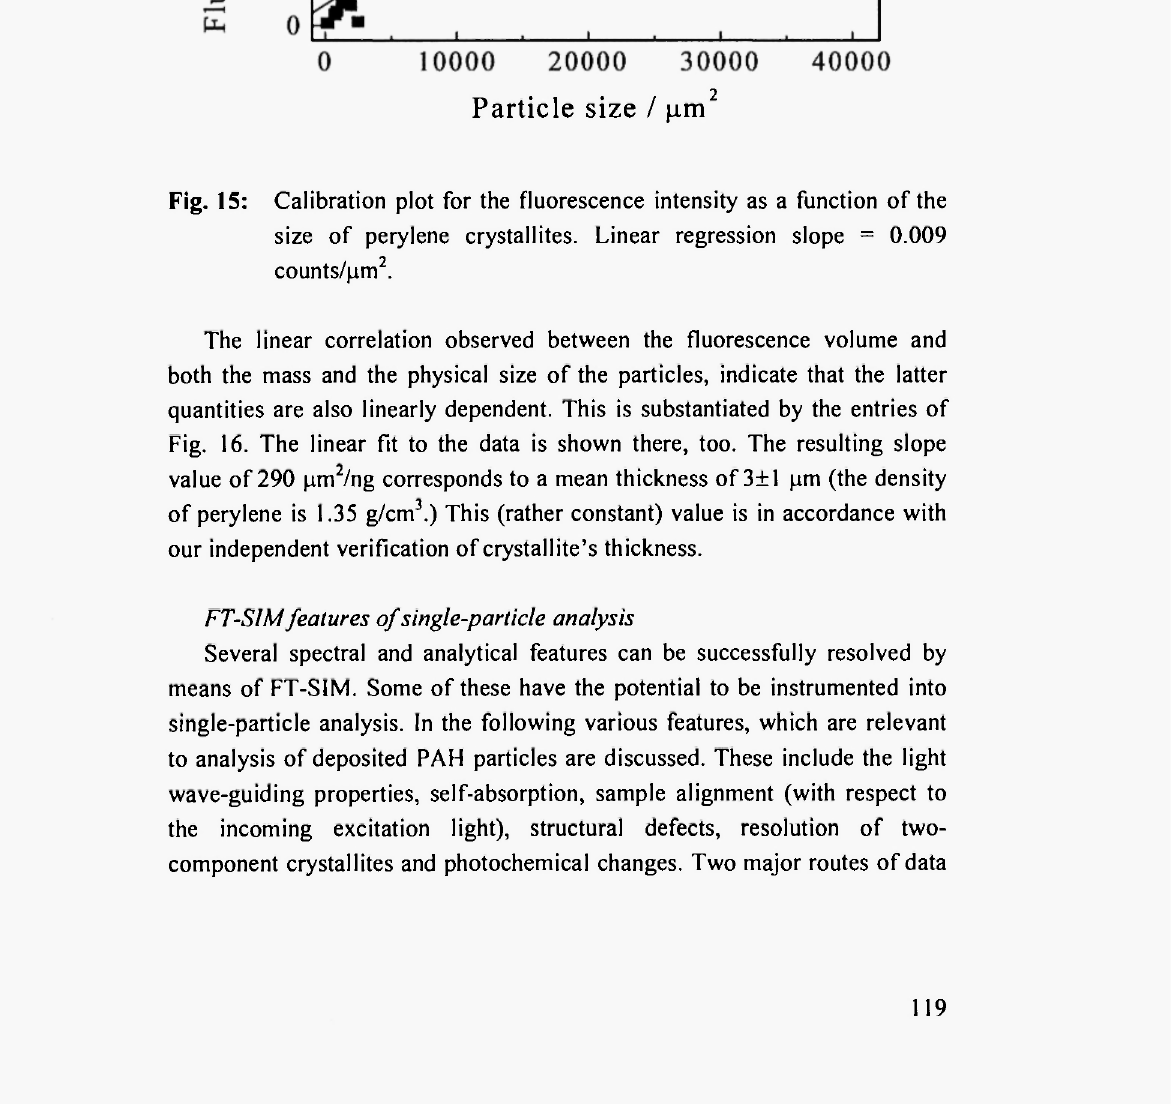
Fig. 15: Calibration plot for the fluorescence intensity as a function of the size of perylene crystallites. Linear regression slope = 0.009 counts/μιτ) 2